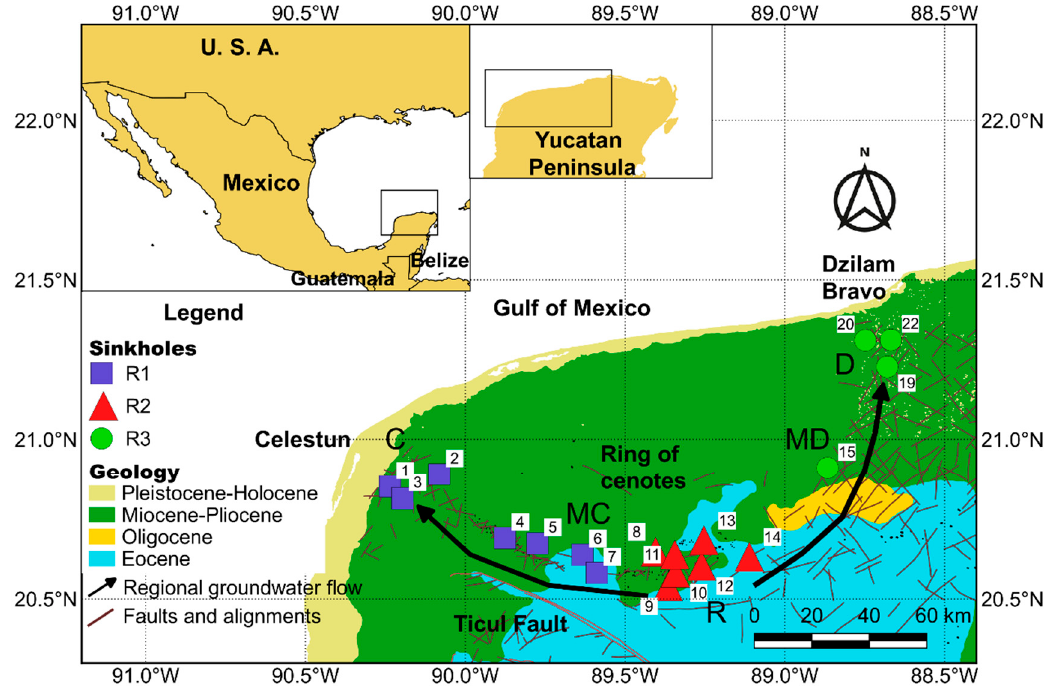
Figure 1. Study area of the Ring of Cenotes (RC). In the map, the surficial geology described by [29–31]. The 18 sinkholes of the study area split into three regions (R1, R2, R3) according to [10]. R is the recharge zone, MC—middle Celestun trajectory, C—Celestun, MD—middle Dzilam trajectory and D—Dzilam. RC’s regional groundwater flow was described by [8] .